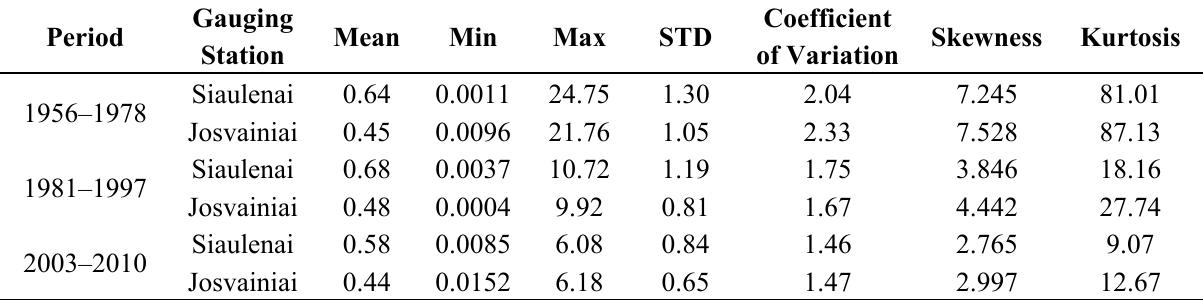
Table 5. Statistical parameters of analysed daily flow (mm/day)